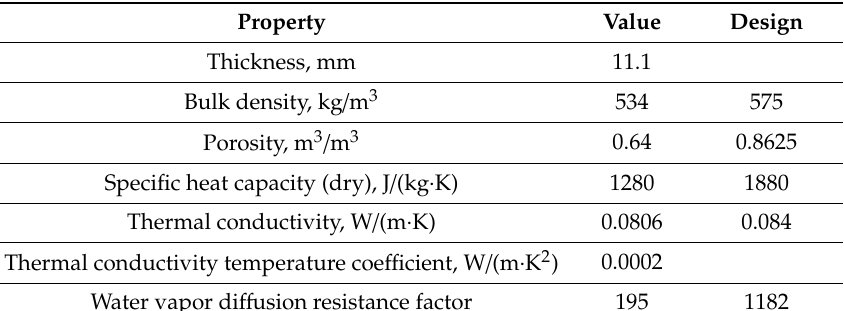
Table A13. OSB property data—improved model and Design values.